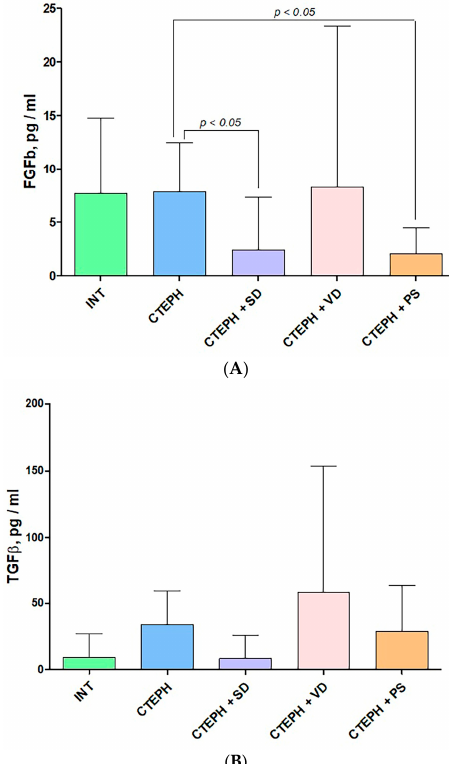
Figure 5. The plasma levels of FGFb ( A ) and TGF β ( B ) in experimental groups. INT—intact animals (n = 6), CTEPH—chronic thromboembolic pulmonary hypertension (n = 6), CTEPH + SD—CTEPH + sympathetic denervation (n = 6), CTEPH + VD—CTEPH + vagus denervation (n = 6), CTEPH + PS—CTEPH + pyridostigmine (n = 6), FGFb—basic fibroblast growth factor, TGF β —transforming growth factor